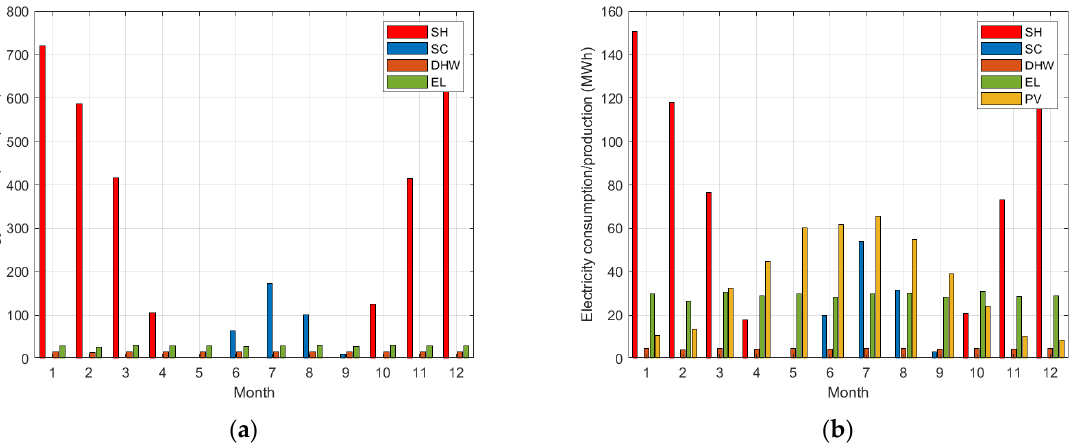
Figure 4. Monthly energy values: ( a ) heating, DHW, cooling and electric consumption; ( b ) electricity consumed and produced.